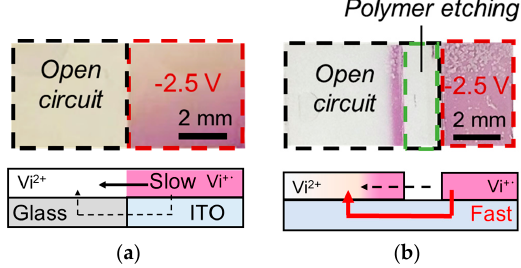
Figure 6. Photographs and structures of electrochromic cells with partially inhibited charge Figure propagation. Charge transport through ITO substrate and polyviologen were inhibited in structure ( a , b ), respectively. Electrolyte solution was 1 M LiCF 3 SO 3 in GBL.